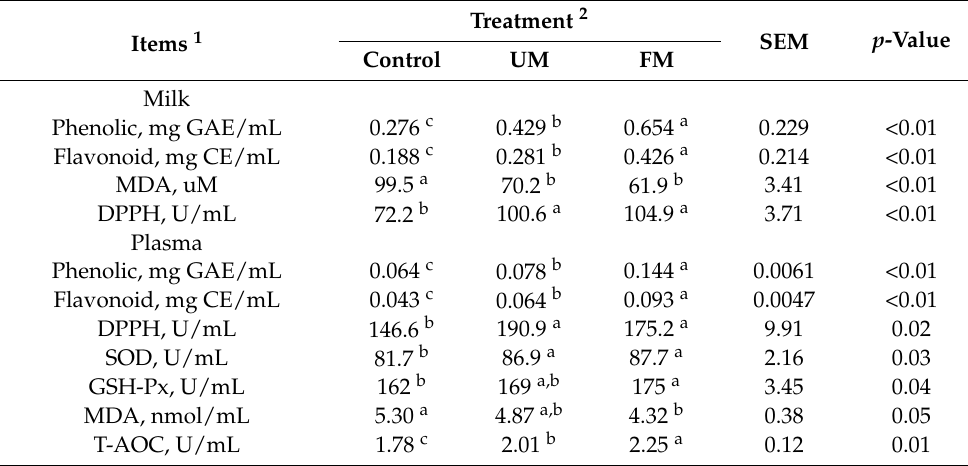
a,b Means within a row with different superscripts differ ( p < 0.05) 1 MCH = average hemoglobin content of red blood cells; fL = µ m 3 , 2 control = TMR containing soybean meal as main protein source; UM = TMR containing UM; FM = TMR containing FM; SEM = Standard Error of Mean. Table 7. Redox variables in plasma and milk of lactating cows fed the total mixed rations (TMR) containing unfermented (UM) and fermented yellow wine lees mix